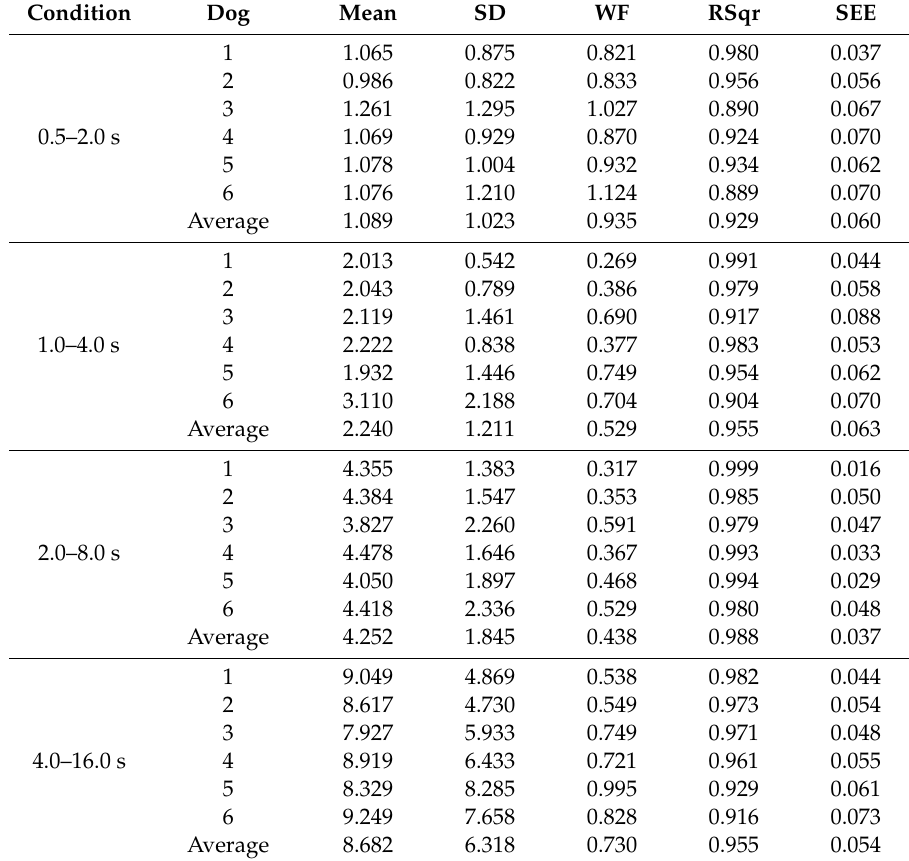
Table 1. The mean, standard deviation (SD), Weber fractions (WF), R-Square (RSqr), and standard error of estimate (SEE) for all dogs, for each of the four conditions derived from nonlinear least squares regression fits of Equation (1) to data for individual